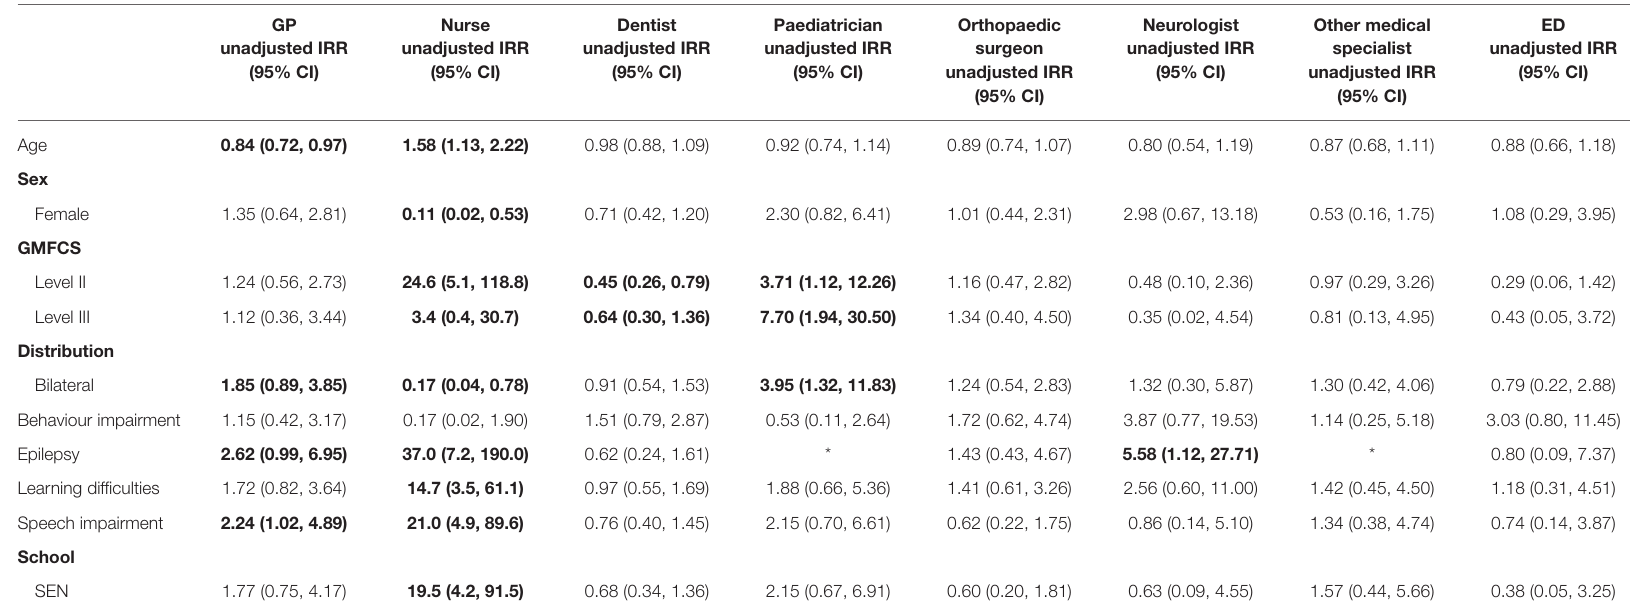
TABLE 7 | Unadjusted associations with number of visits to a general practitioner, nurse, dentist, paediatrician, orthopaedic surgeon, neurologist, other medical specialist and emergency department.